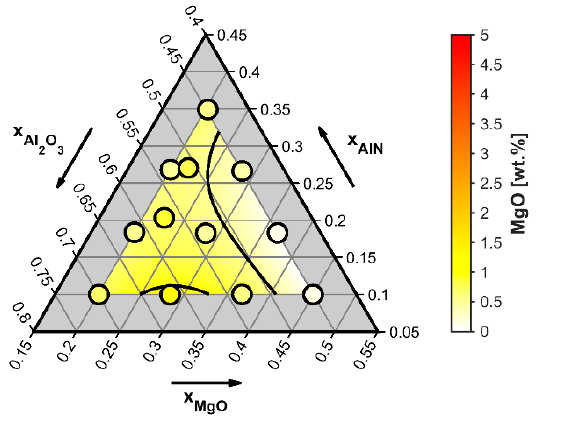
Figure 6. Weight percentages of formed and remaining initial phases as a function of initial compo- sition within the quasi-ternary MgO-AlN-Al 2 O 3 system after 3 h ( a – d ) and 6 h ( e – g ) of sintering at 1500 °C in nitrogen atmosphere. The weight percentages were obtained from XRD analysis (see Supplementary Table S1). The solid black contour lines mark the constant weight percentages of the respective compound. The weight percentages of MgO are not presented for 6 h, as its content had already decreased to nearly 0 wt% for all samples after 3 h of sintering. Panel ( h ) shows the positions of the samples from Tables 3 and 5 in the composition diagram along with the respective lines of the phase diagram proposed by Willems [4] for direct comparison.